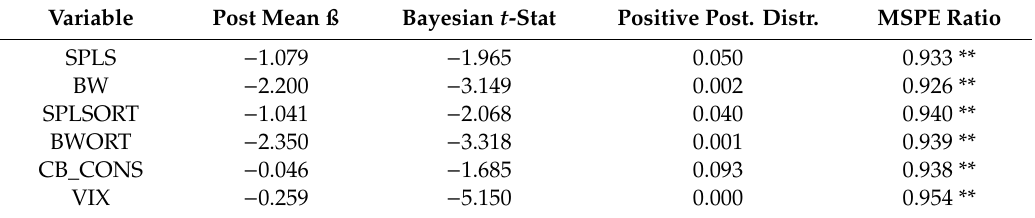
Table 1. Set of regressions run on the U.S.